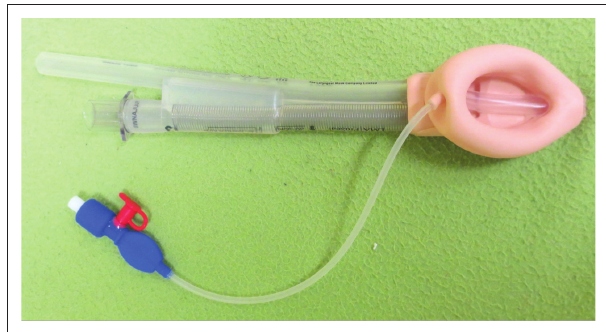
FIGURE 6: ProSeal laryngeal mask airway devices (second